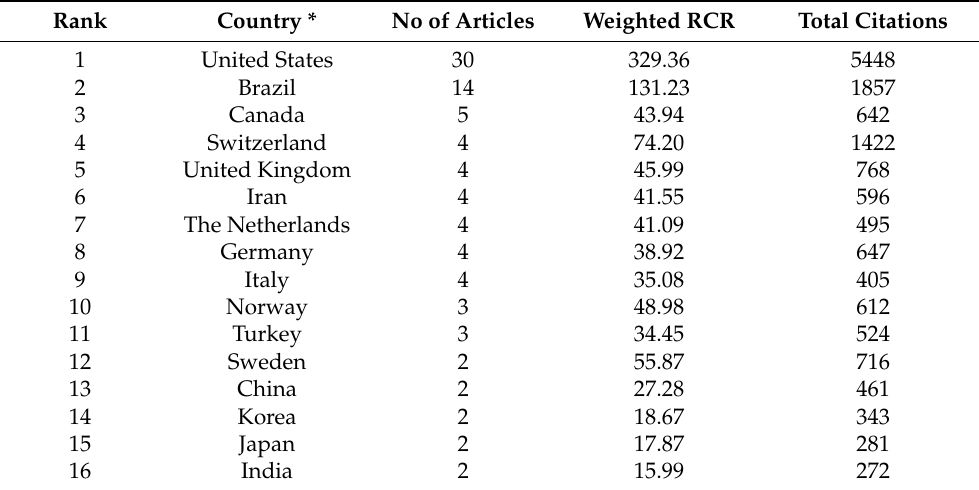
Table 3. Countries that contributed with at least two articles to the top 100 most influential root canal disinfection articles with the highest relative citation rates (RCRs):